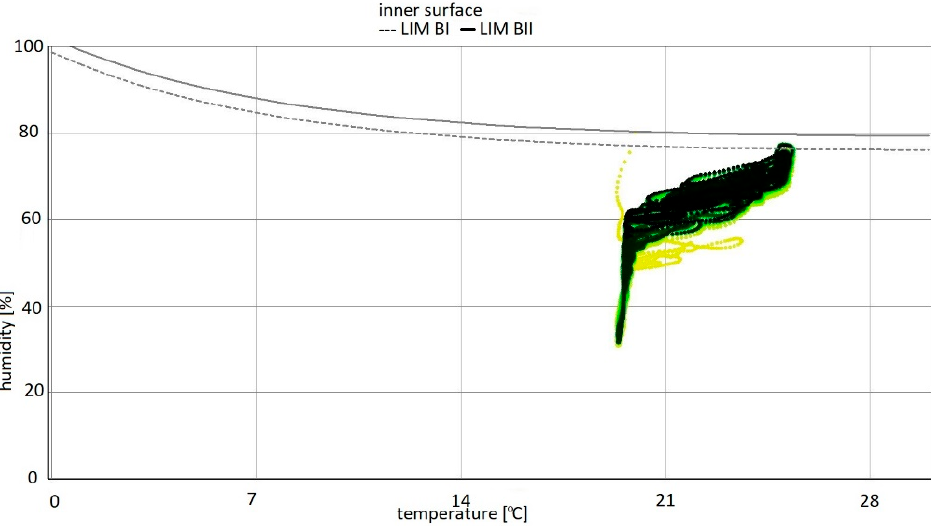
Figure 17. Isopleth of the inner surface of the partition, variant 5 [70]. The isopleths of the LIM B I (dashed line) and LIM B II (solid line) curves i.e., contour charts of the mould growth rate as a function of temperature (horizontal axis) and humidity (vertical axis), do intersect with the area of points for the partition analysed. The risk of mould development appeared at a minimum relative humidity of 78% and a temperature of approx. 24 ◦ C (Figure